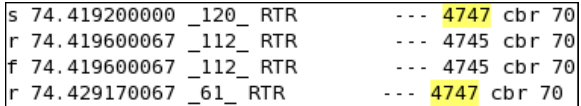
Figure 8. Packet transfer with encryption.